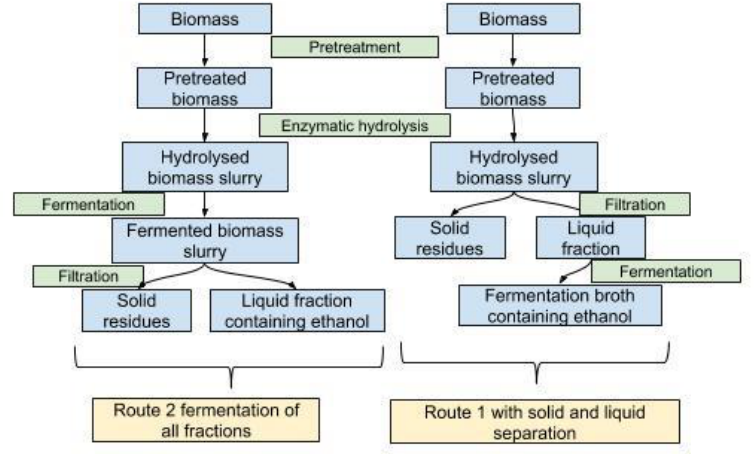
Fig. 1. A flow chart of the studied routes of biomass for biofuel